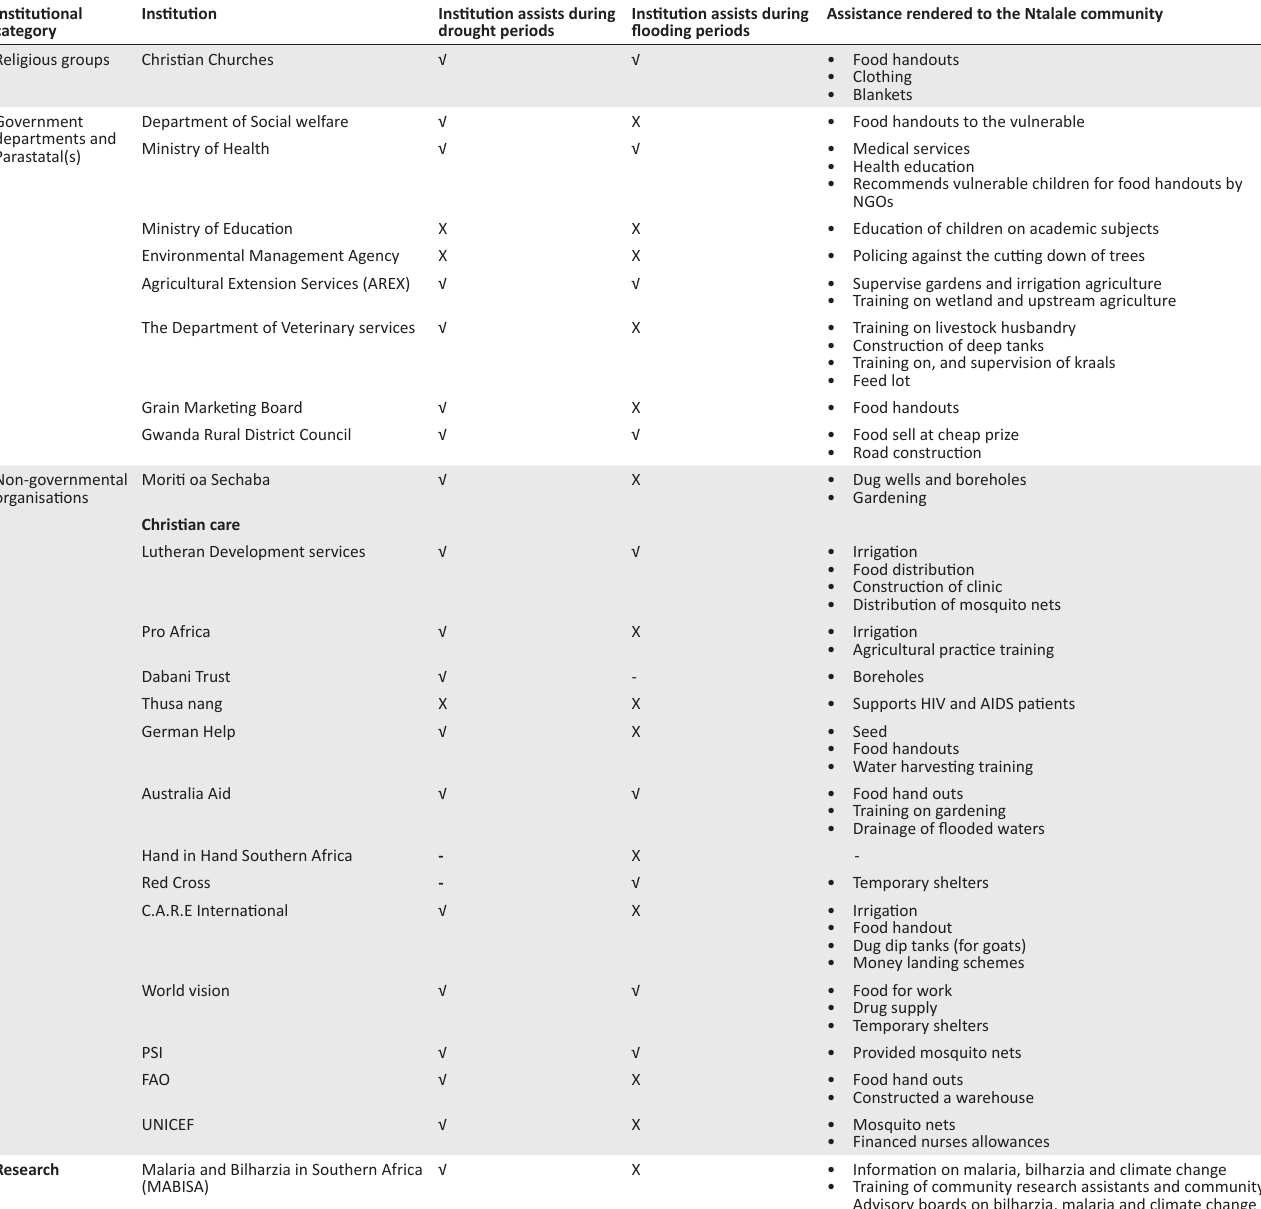
TABLE 2: Reported institutions operating in Ntalale ward during droughts and floods and the nature of assistance. Institutional